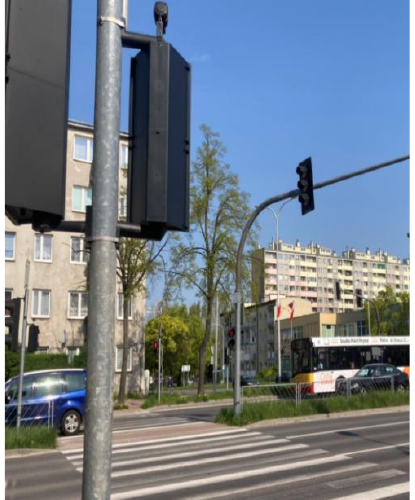
Figure 11. Observation site: pedestrian crossing number 3.